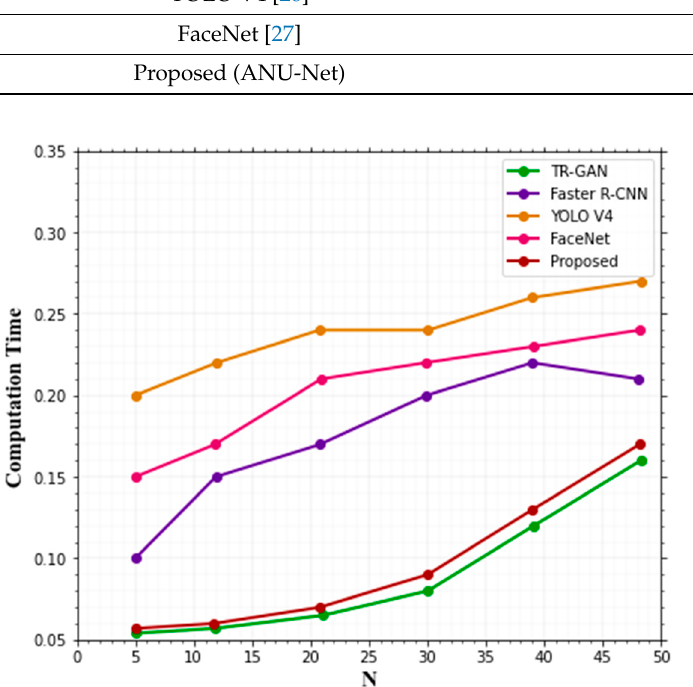
Figure 9. Comparing the time complexity of the suggested approach to the existing techniques.